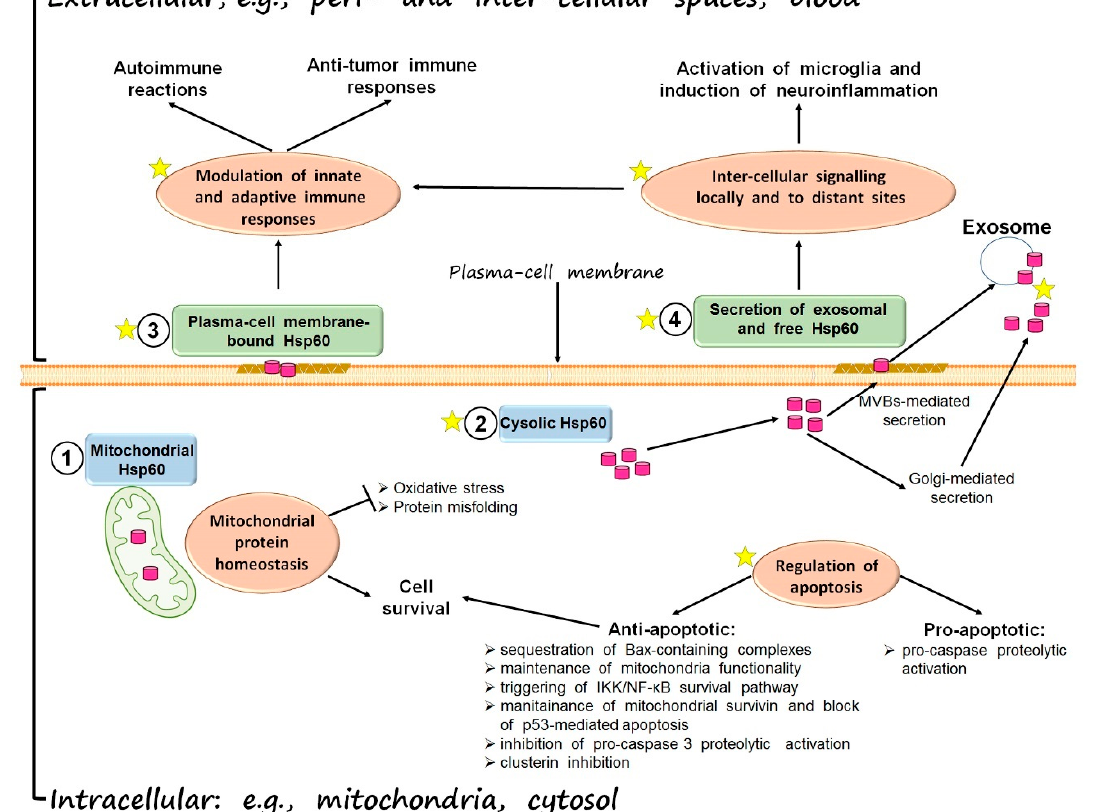
Figure 1. Hsp60 plays multiple roles intra- and extracellularly. Its canonical functions pertain to maintenance of protein homeostasis inside mitochondria, whereas its non-canonical roles are unrelated to protein quality control and are played in a variety of locations (shown with a yellow star). The chaperonin (small dark-pink cylinder) is typically in the mitochondrion matrix (1) in which it assists in the folding of intra-mitochondrial proteins, for instance those of the electron transport system, and therefore it is a vital molecule for maintaining cell viability and organismal physiology under normal conditions and in the face of stress. Consequently, Hsp60 chaperonopathies are usually serious conditions. The non-canonical functions of Hsp60 displayed in a variety of locations beyond the mitochondria, for example in the cytosol (2), are also vital. One example is regulation of apoptosis, which can be in either direction pro- or anti-apoptotic with implications for carcinogenesis. The anti-apoptotic effect of Hsp60 helps cancer cells to become immortal. In the plasma-cell membrane (3), Hsp60 can be recognized by immune cells and antibodies and generate immune reactions that damage the cell, which is a welcome event if the target cell is a cancerous one, but it is a pathogenic reaction when the cell is a normal one, a vascular epithelial cell, for instance, generating autoimmune conditions. Hsp60 exits cells (4) via different mechanisms and can, thus, reach molecules in the extracellular space and other cells nearby and far away, the latter via blood free or on particles, such as platelets, red cells, and microvesicles, like exosomes. In this manner, Hsp60 plays a role in intercellular communication, as illustrated by the microglia activation that occurs in some neurodegenerative diseases via the Hsp60-TLR-4-NF- κ B signaling pathway.